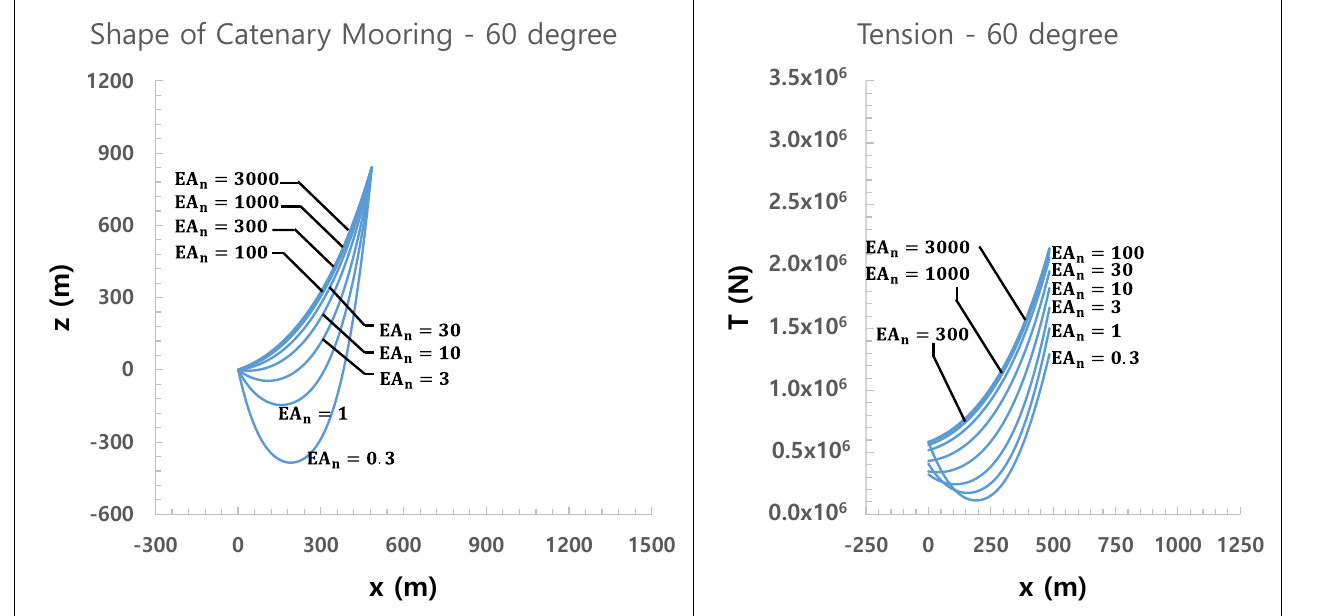
Figure 8. Results for static analysis of mooring line when q is 60°. The contact force of the seabed was computed using the above equation. An example of the mooring line is shown in Figures 9–12, which depict the static equilibrium position and tension of the numerical example. The slope angle q was varied from 20° to 60°. The analysis results show a parabolic catenary curve shape. The sag increases quadratically with a decrease in the axial stiffness (the axial stiffness is proportional to EA). Moreover, the tension of the mooring line decreases with the axial stiffness, which suggests that the mooring force also decreases.